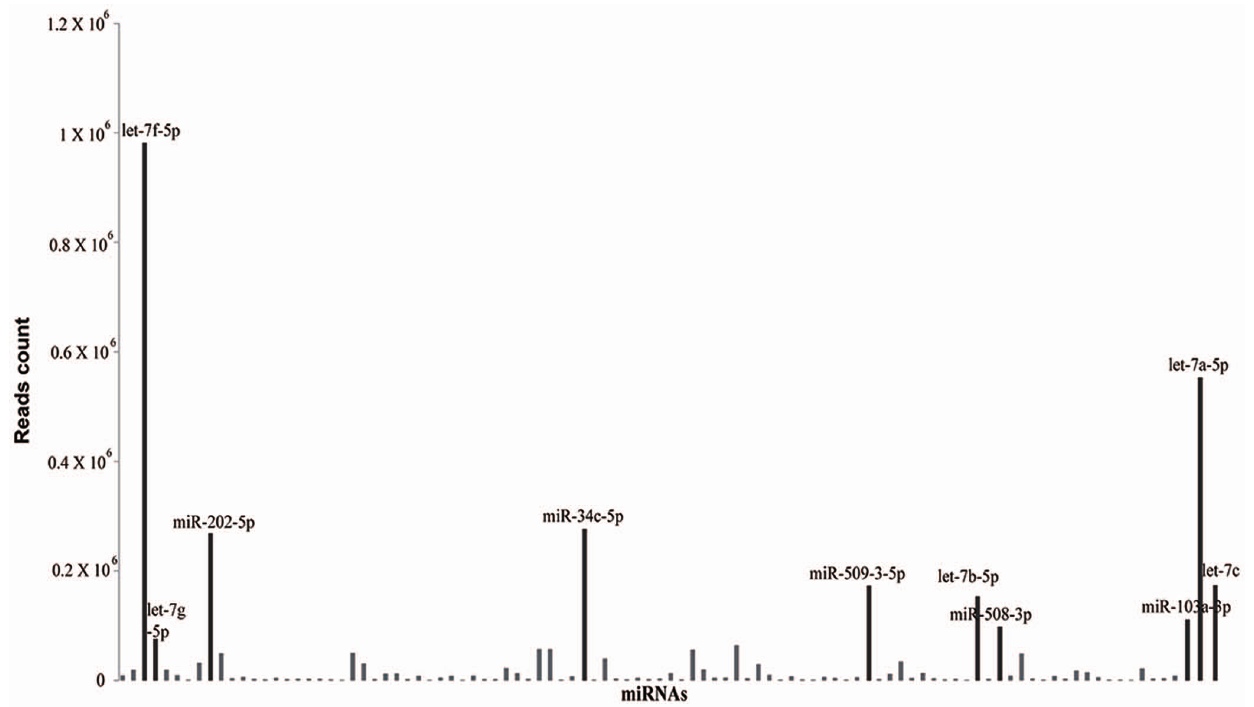
Figure 2. The expression profile of top abundant known miRNAs. Out of the 770 known miRNAs detected, the top 10 miRNAs were named.